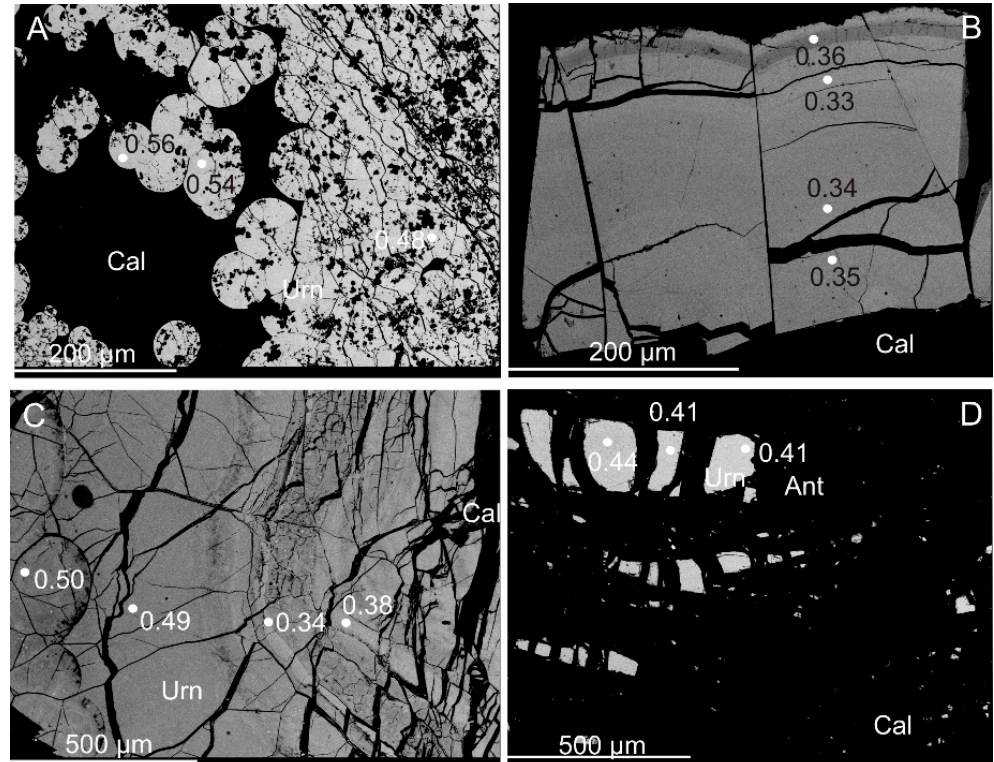
Figure 6. Back-scattered electron (BSE) images of uranium mineralization with distribution of Ca ( apfu , O = 4) in uraninite, Pˇr í bram uranium district. ( A ) Botryoidally evolved aggregates of uraninite; ( B ) Detailed distribution of Ca in botryoidally evolved uraninite; ( C ) Detailed distribution of Ca in partly zoned uraninite; ( D ) Distribution f Ca in uraninite included in anthraxolite. Urn—uraninite, Cal—calcite,